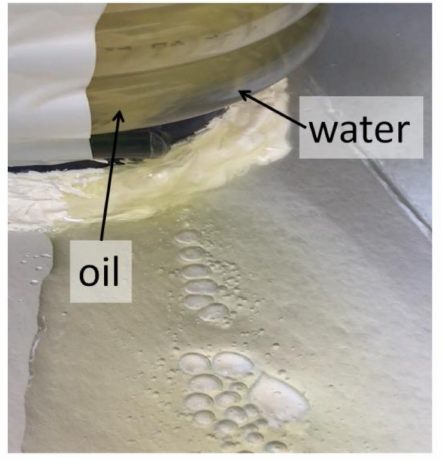
Figure 10. Example of test made: the main part of the water flow rate is present on the outer side of the separator and the oil flow rate is basically placed on the inner